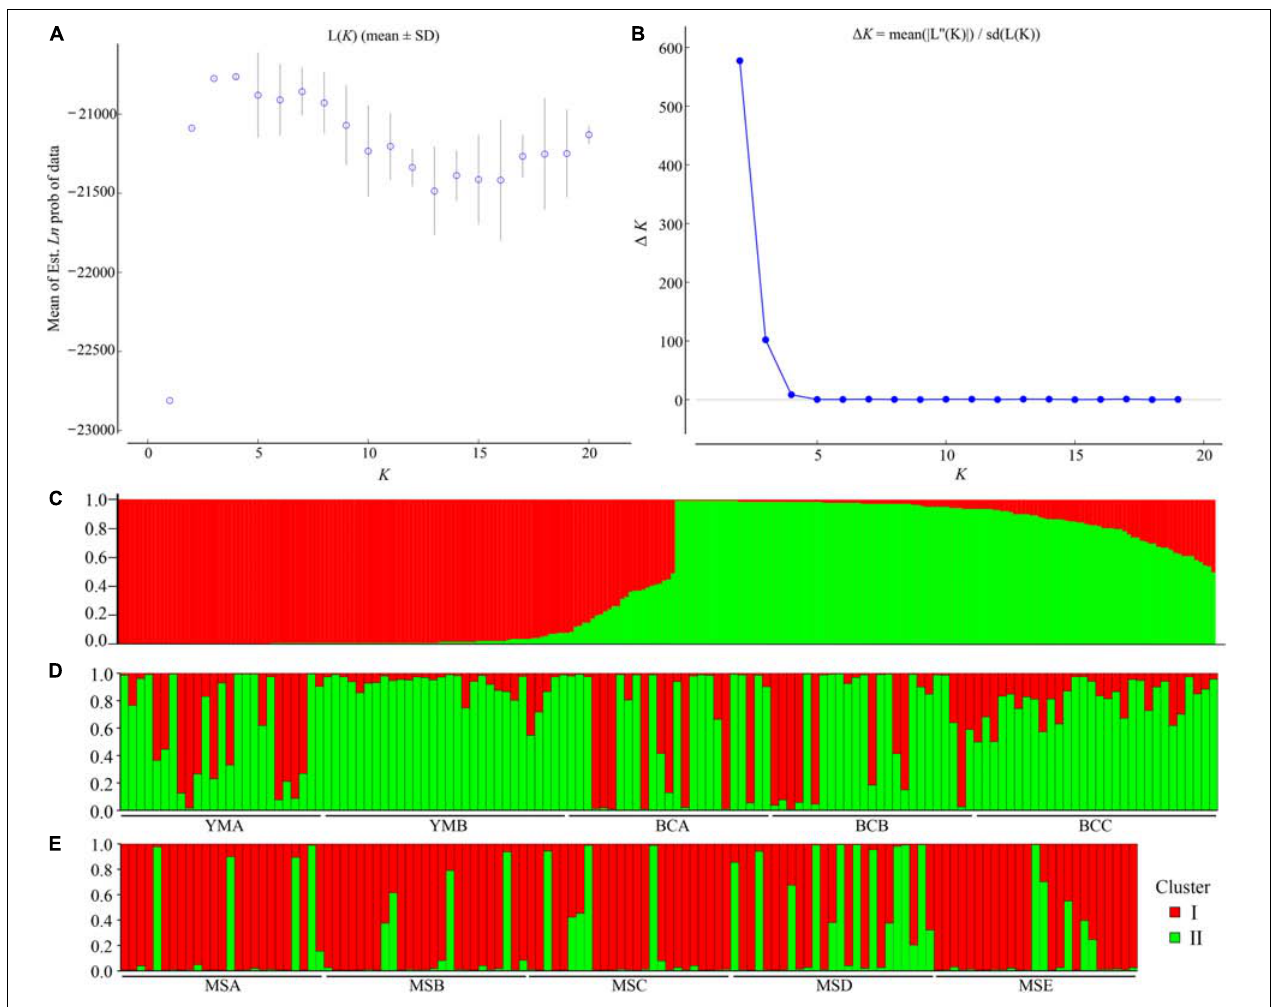
FIGURE 6 | Bayesian model-based clustering STRUCTURE analysis of 260 individuals of P. emblica . (A) Mean log-likelihood [Ln( K ) ± SD] against the number of K ; (B) (cid:49) K values for different numbers of clusters ( K ); (C–E) Estimated population structure of 260 Phyllanthus emblica individuals on K = 2: (C) bar plot was sorted by Q -values in single line, and (D,E) bar plot was grouped by population ID in multiple